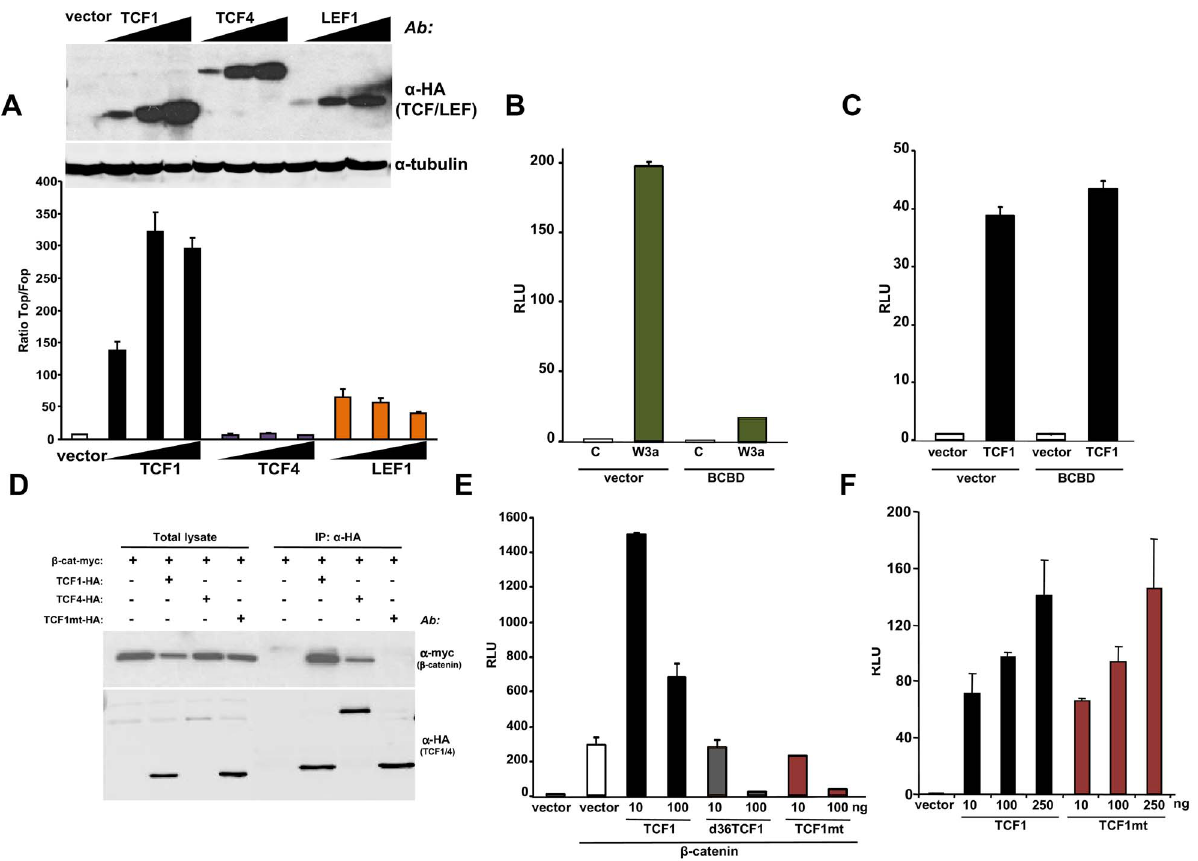
Figure 2. b -catenin-independent transcriptional activity of TCF1/LEF1 factors. (A) Empty pcDNA3HA vector or increasing amounts of HA- tagged TCF1, LEF1 or TCF4 constructs were co-transfected with SuperTop or SuperFop and renilla luciferase plasmids in 293T cells and the Top/Fop ratio was calculated. (B–C) Effects of a decoy construct containing TCF1 b -catenin binding domain (BCBD) on Wnt3a- and TCF1-induced TCF/LEF reporter activity. 293T cells were co-transfected with SuperTop and renilla reporter plasmids, together with the Wnt3a, TCF1 and BCBD vectors as indicated. (D–E) Mutant TCF1 (mtTCF1; D21A, E29K) is unable to bind to b -catenin. (D) 293T cells were transfected with the indicated HA-tagged TCF1 or TCF4 constructs and the myc-tagged b -catenin, followed by immunoprecipitation using anti-HA antibody and immunoblot with anti-myc or